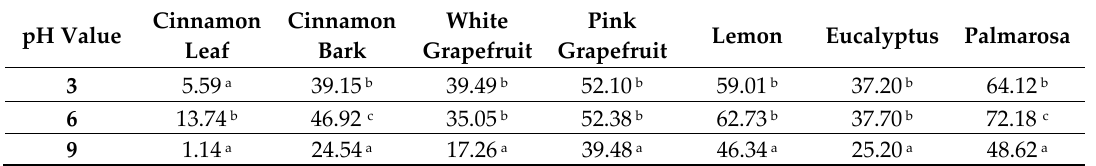
Figure 4. The effect of pH on reduction of deoxynivalenol concentration at 20 °C. The experiment was conducted up to 72 h. Data were analyzed by Tukey’s test at p < 0.05 ( a , b , c — significantly different in column).